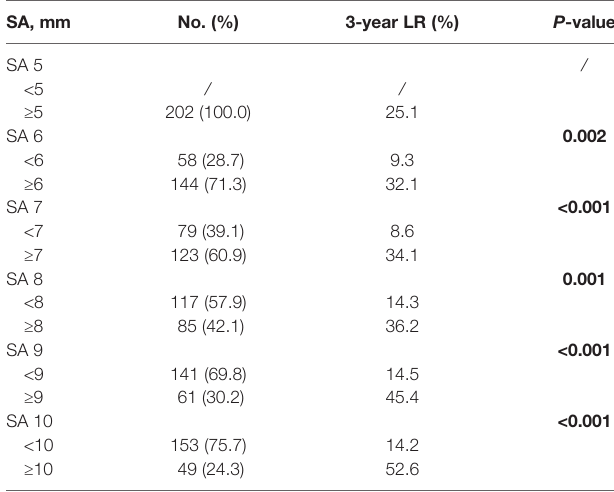
TABLE 3 | Three-year local recurrence rates for different cutoff values in SA on baseline MRI in patients with lateral node metastasis. SA, mm No. (%)